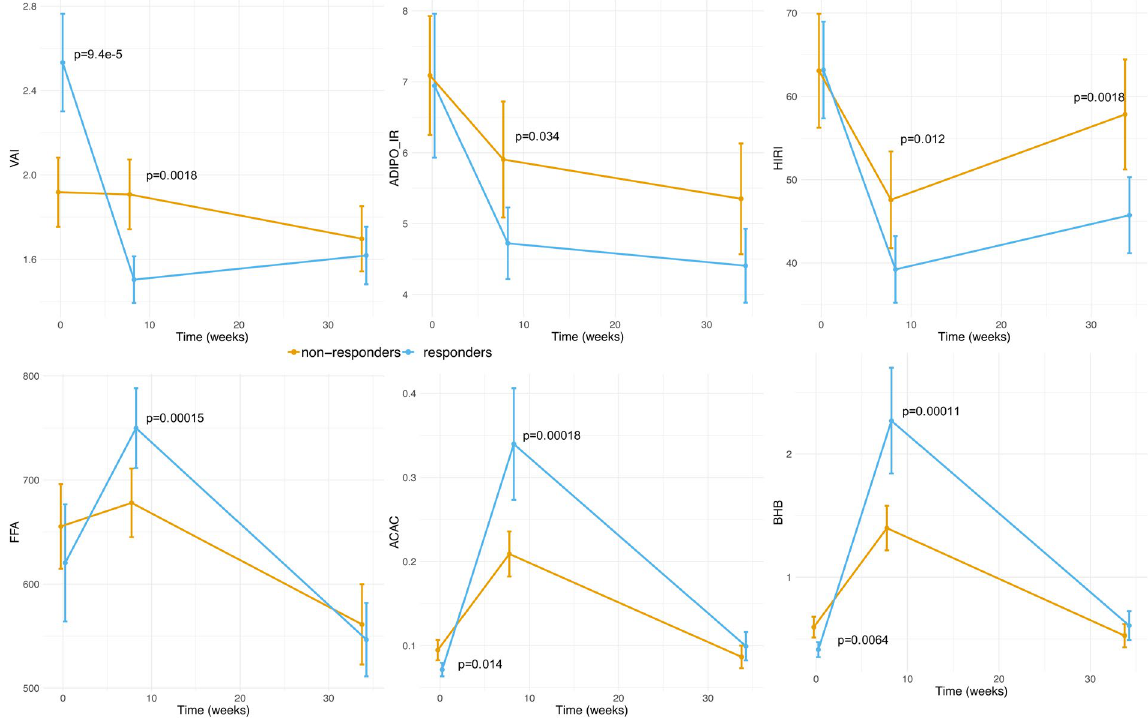
Figure 3. Evolution of visceral fat, tissue-specific IR indices, free fatty acid and ketone bodies during intervention. Data are shown as mean + / − 95% CI per group (responders/non-responders). P-values compare the difference between responders and non-responders at a given CID. Those p-values are adjusted for gender, age and center. P-values greater than 5% are not